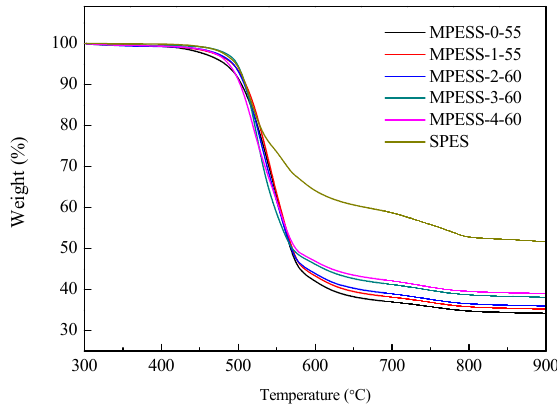
Figure 12. TGA curves of the prepared PES hollow fiber membranes. Table 3. Thermal decomposition temperature of the prepared PES/SPES membranes.